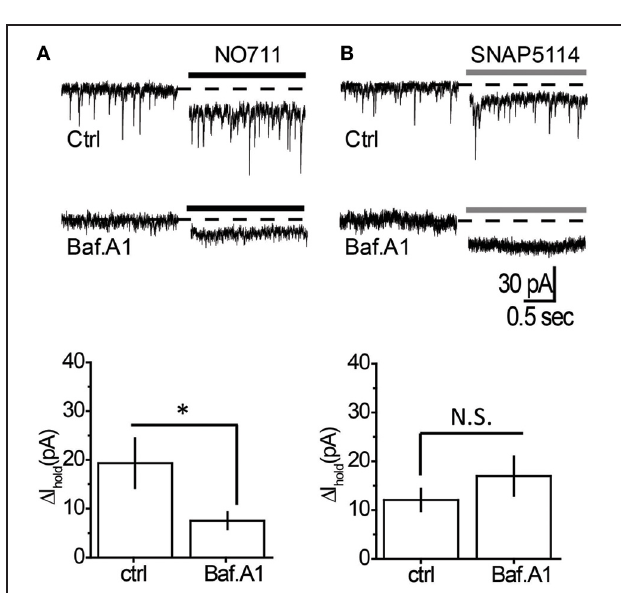
FIGURE 4 | Tonic GABA A current mediated by non-vesicular GABA release is regulated by mGAT3/4, but not by mGAT1. (A) Top : Changes in I hold produced by NO711 in control ( upper trace ) or bafilomycin A1-treated slices ( lower trace ). Dashed line —baseline level of I hold , black line —application of NO711. Bottom : Summary graph showing changes in I hold produced by NO711 in control (ctrl, n = 6) and bafilomycin A1-treated (Baf. A1, n = 6) slices. (B) Top : Changes in I hold produced by SNAP5114 in control ( upper trace ) or bafilomycin A1-treated slices ( lower trace ). Dashed line —baseline level of I hold , gray line —application of SNAP5114. Bottom : Summary graph showing changes in I hold produced by SNAP5114 in control (ctrl, n = 7) and bafilomycin A1-treated (Baf. A1, n = 6) slices. ∗ P < 0 . 05; N.S. P > 0 . 05, unpaired t -test.